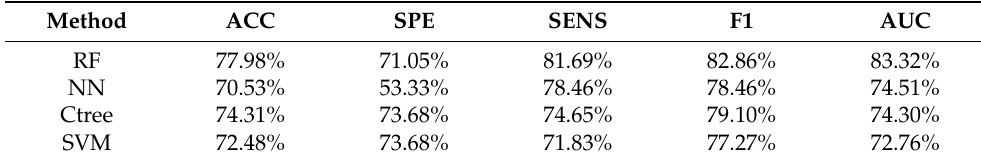
Table 2. Results of the implemented experiments in 10-fold cross-validation. Method